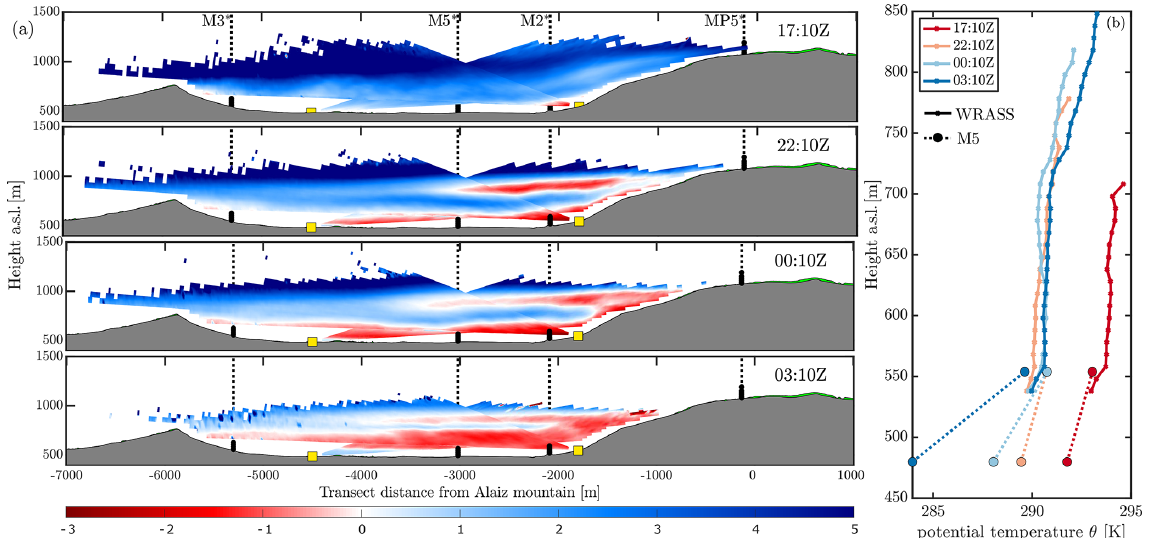
Figure 12. Panel (a) shows the superposition of dual RHI scans during the layered valley winds period between 24–25 October 2018. Panel (b) shows the potential temperature profiles measured by the windRASS and M5 at each frame in panel (a) .